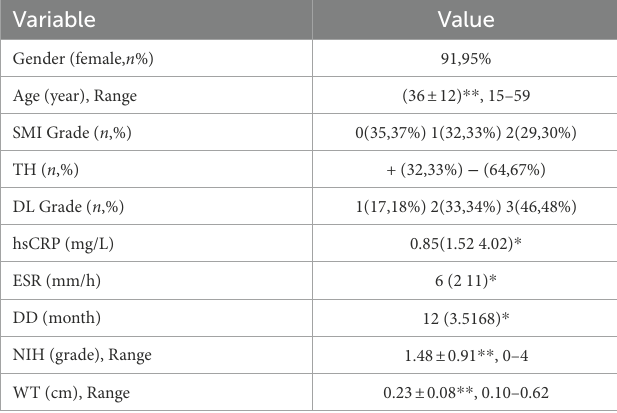
TABLE 1 Clinical data of Takayasu’s arteritis patients n = 96.